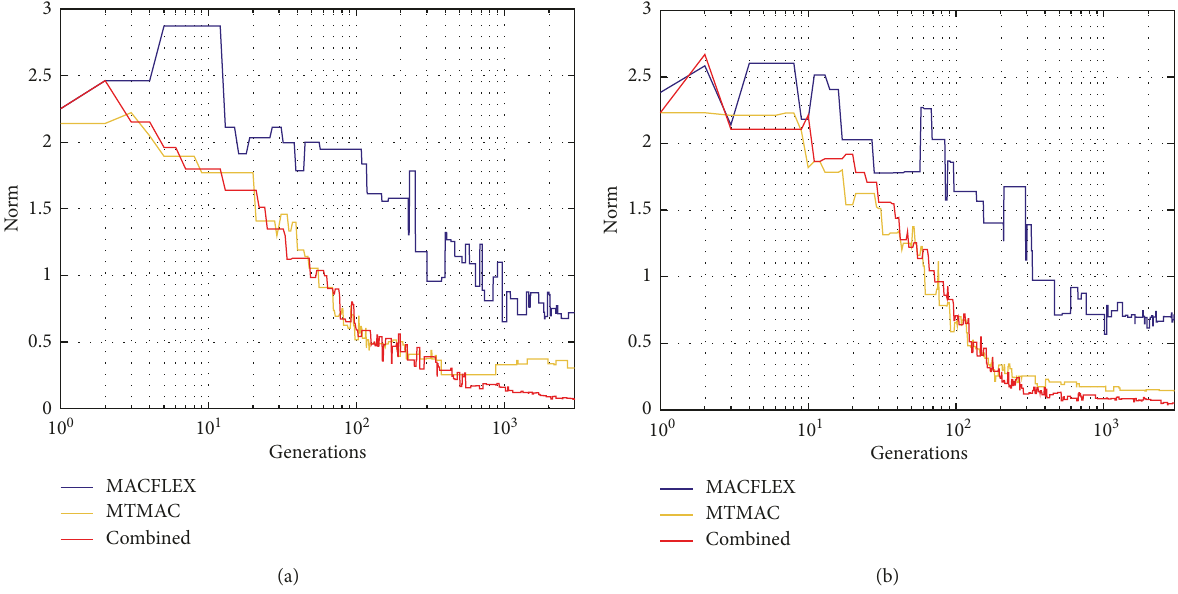
Figure 15: Frame example: norm values for the three objective functions versus generations, for three known eigenmodes, for damage scenarios 2 and 3 (no noise). (a) Scenario 2 and (b) scenario 3. Table 4: Frame example: norm values for different criteria and damage scenarios (no noise, 3 known eigenmodes). Criterion